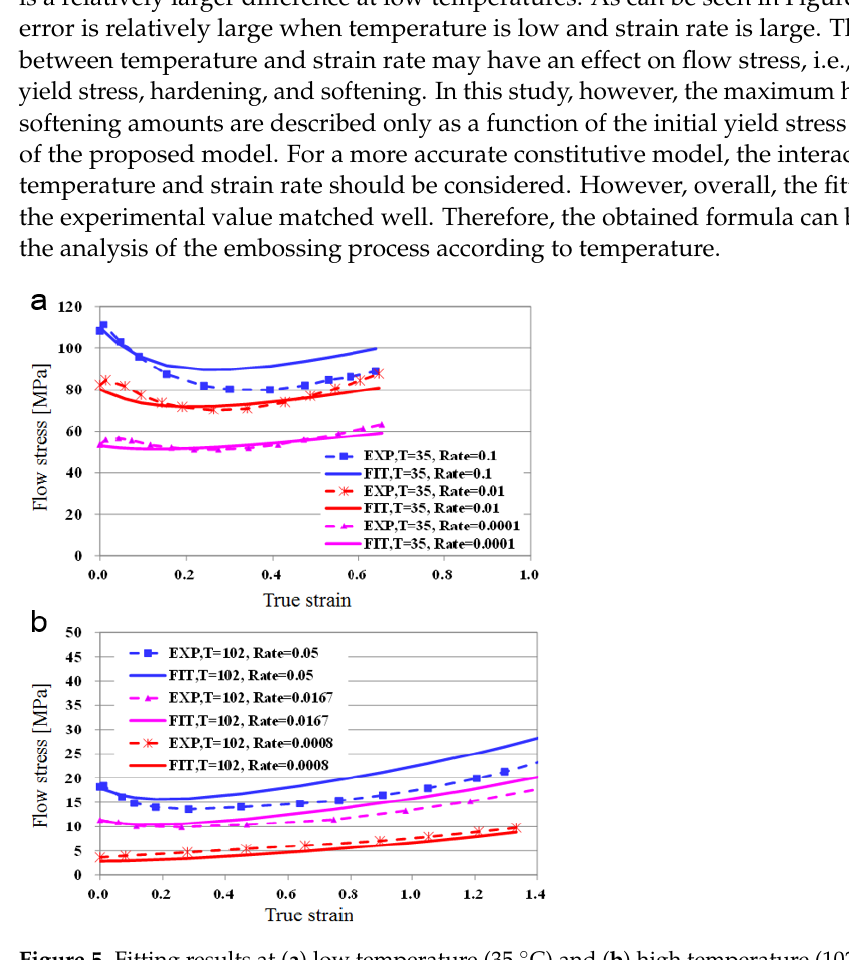
Figure 6. Fitting results for a wide range of temperatures at a low strain rate. 3.2. Finite Element (FE) Modeling and Case Study Next, a finite element analysis of the PMMA film was performed using the flow stress model for the material obtained from the previous section. ABAQUS was used for the analysis and a user subroutine was developed in order to use the obtained flow stress model. In a large deformation analysis, “re - meshing” is required when elements are severely deformed. Abaqus provides an ‘ALE’ technique to overcome this severe deformation problem. In the hot embossing process, heat transfer takes place between the hot die and cool film during forming, and this heat transfer has a great effect on the forming quality. Accordingly, a transient heat transfer analysis needs to be performed together with the deformation analysis. Therefore, the ‘Explicit’ analysis was employed to predict the heat transfer and deformation together. The overall equilibrium equation for explicit dynamic analysis is written as follows [19]: